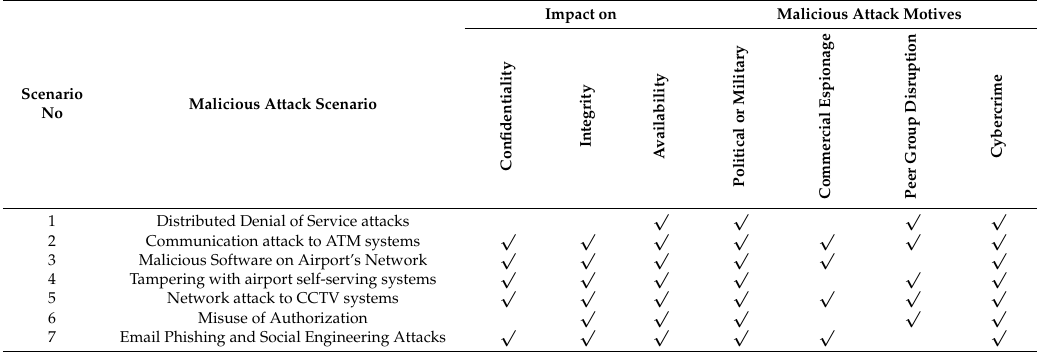
Table 2. Malicious attack motives